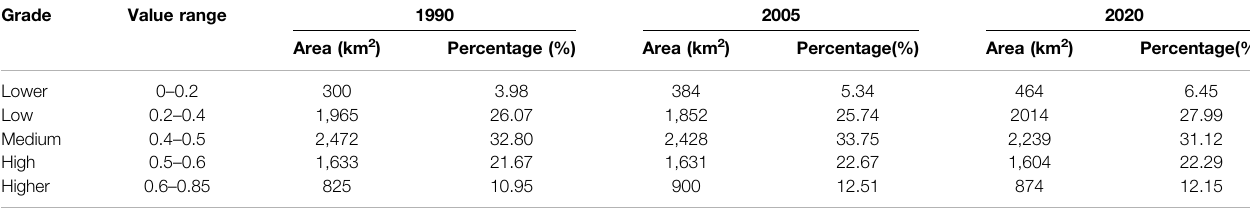
TABLE 10 | Area and proportion of each grade of comprehensive resilience level of the ecosystem in Nanchang. Grade